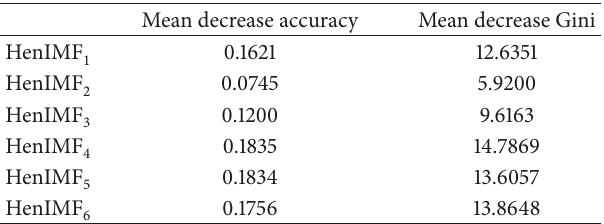
Table 5: The effect of energy entropy on accuracy and Gini